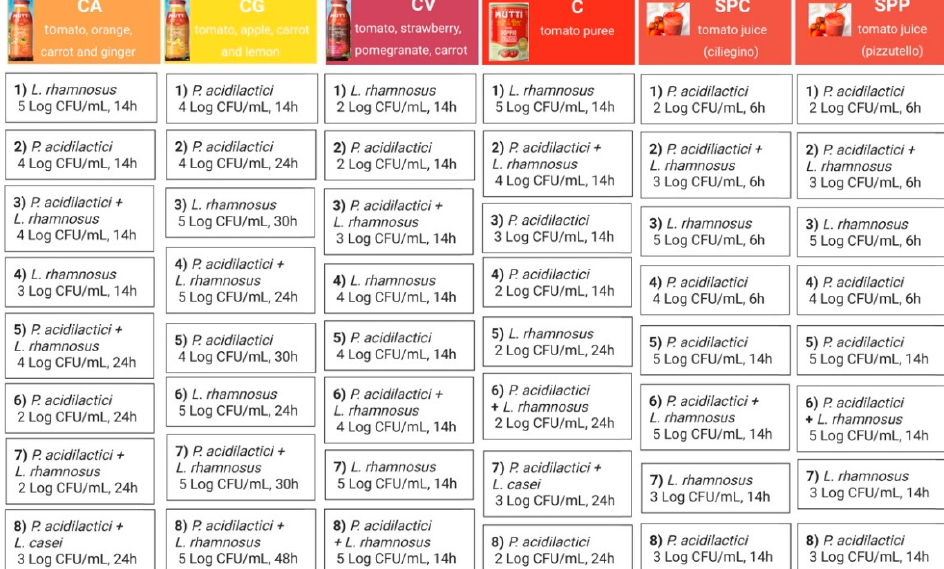
Figure 2. Combination of strains and co-cultures selected for each matrix, inoculum size (Log CFU/mL) and fermentation time. These combinations were used both for pasteurized (TT) and refrigerated (NTT) samples.